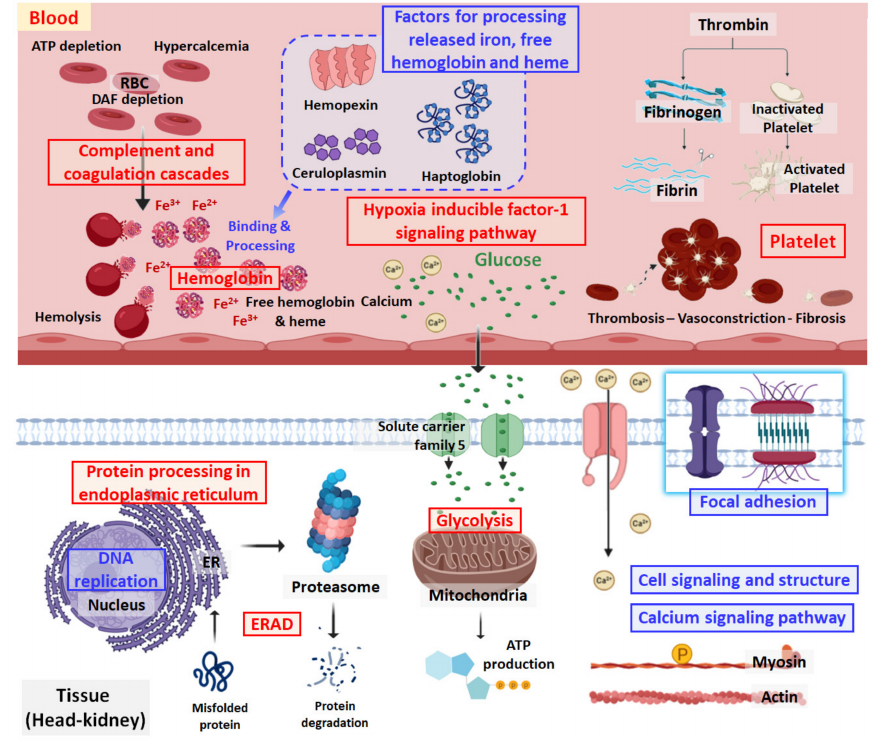
Figure 10. Schematic diagram showing systemic changes in rainbow trout under acute thermal stress. The red and blue boxes indicate featured up- and down-regulated biological responses, respectively. The figure was drawn using Biorender (https: // biorender.com /